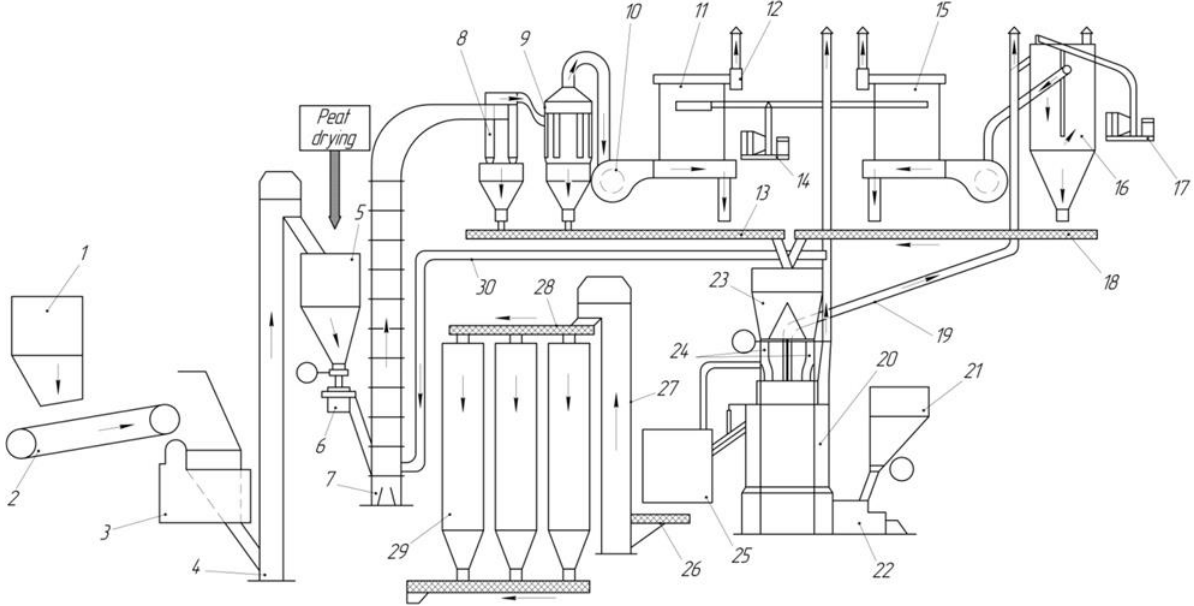
Figure 8. Technological scheme for the production of modified gypsum binder. 1 : gypsum stone bunker; 2 : conveyor belt; 3 : jaw crusher; 4 : chain elevator; 5 : bin feeder for crushed gypsum rock; 6 : disk feeder; 7 : shaft mill (paddle type); 8 : cyclones; 9 : cyclones battery; 10 , 12 : fans; 11 , 15 : sleeve filters; 13 , 18 : screw conveyors; 14 , 17 : heaters; 16: dust condensing chamber; 19 : steam pipe; 20 : gypsum cooker; 21 : solid fuel bunker; 22 : furnace; 23 : gypsum powder bunker; 24 , 26 : feeders; 25 : malleableising bunker; 27 : elevator; 28 : screw conveyor; 29 : gypsum binder silo; 30 : gas